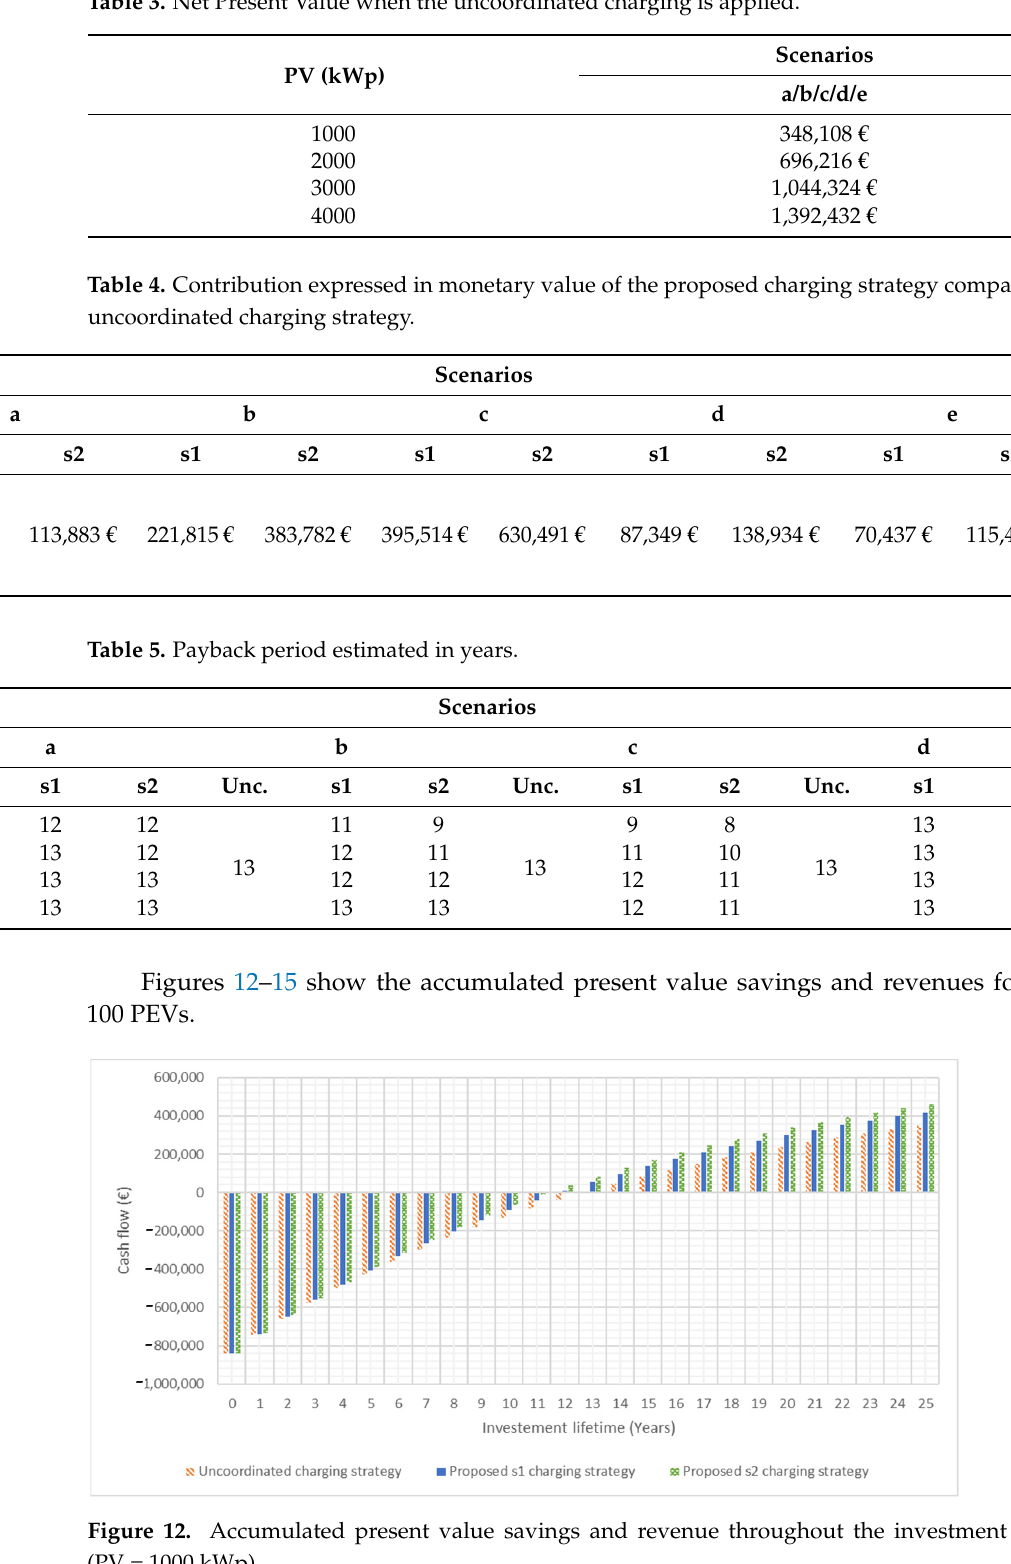
Figure 13. Accumulated present value savings throughout the investment years (PV = 2000 kWp). Figure 14. Accumulated present value savings throughout the investment years (PV = 3000 kWp).